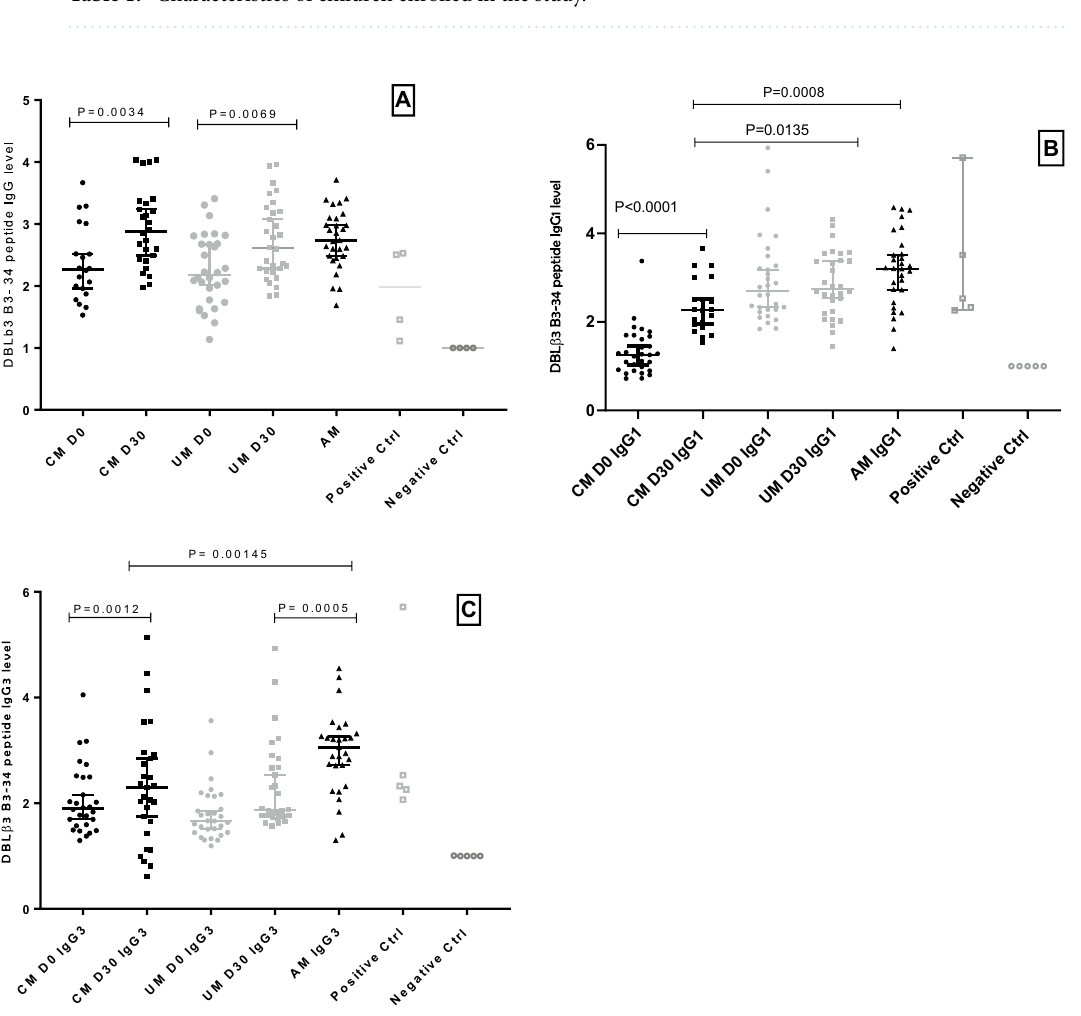
Table 1. Characteristics of children enrolled in the study.